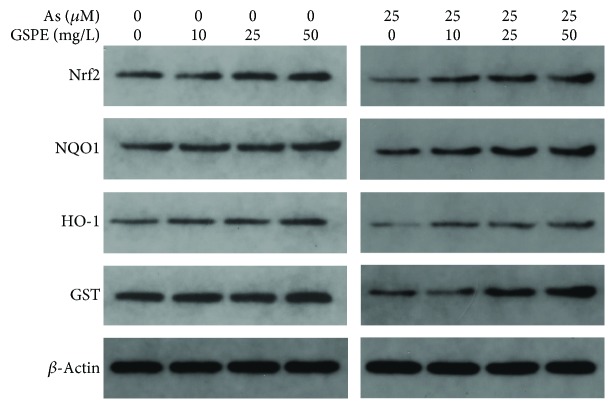
Western blot analysis of proteins after treatment with arsenic and/or grape seed procyanidin extract. Nrf2, NQO1, HO-1, and GST protein expression was measured in L-02 cells treated with arsenic and/or grape seed procyanidin extract by western blotting. Treatment with GSPE (25 and 50 mg/L) significantly elevated the protein contents of Nrf2, NQO1, HO-1, and GST in a dose-dependent manner compared with the control group. Compared with the control group, arsenic (25 μM) markedly decreased the protein expression of Nrf2 and its downstream genes after 24 h. However, the protein contents of Nrf2, NQO1, HO-1, and GST in the arsenic + GSPE group increased gradually compared with the contents in the arsenic group.